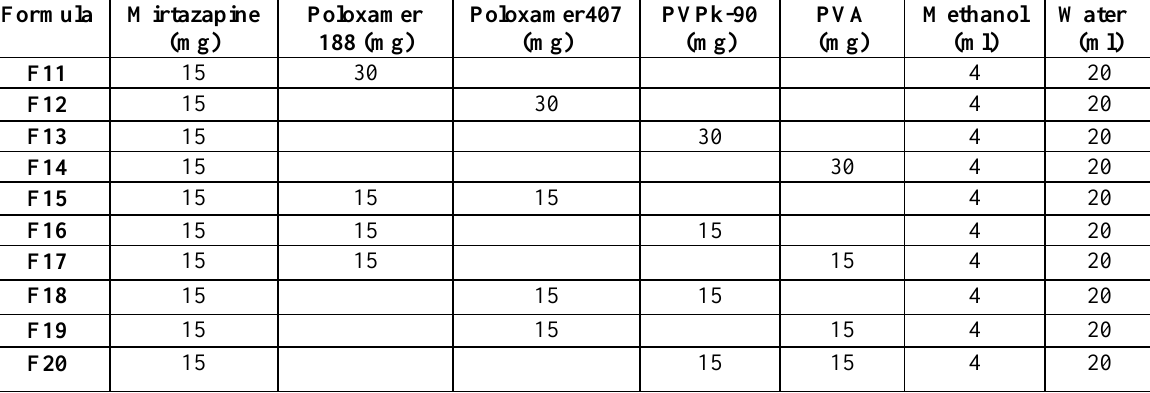
Table2. Composition of mirtazapine nanosuspension using different stabilizers at drug: stabilizer ratio